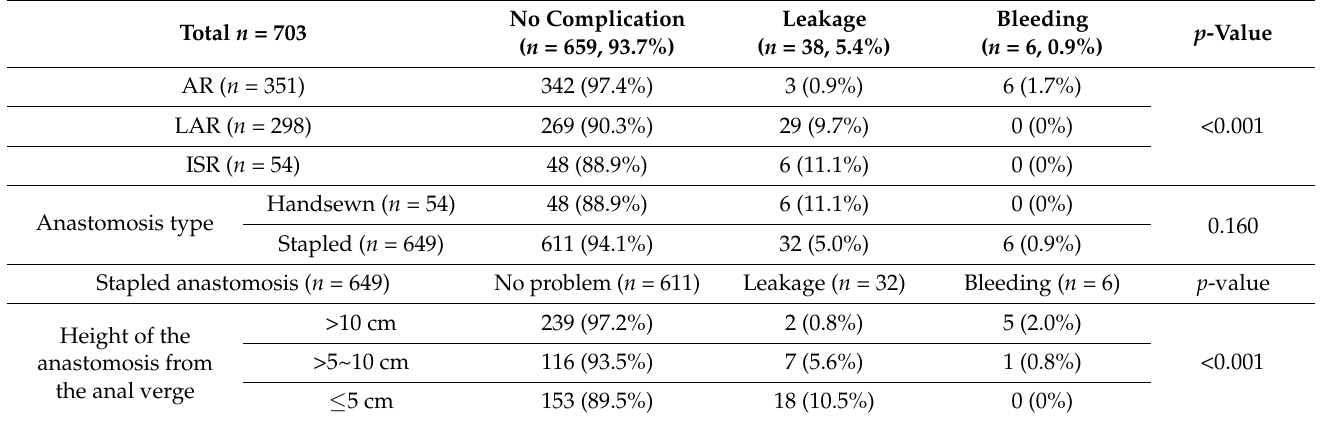
Table 1. Rate of anastomotic complications for left-sided colorectal